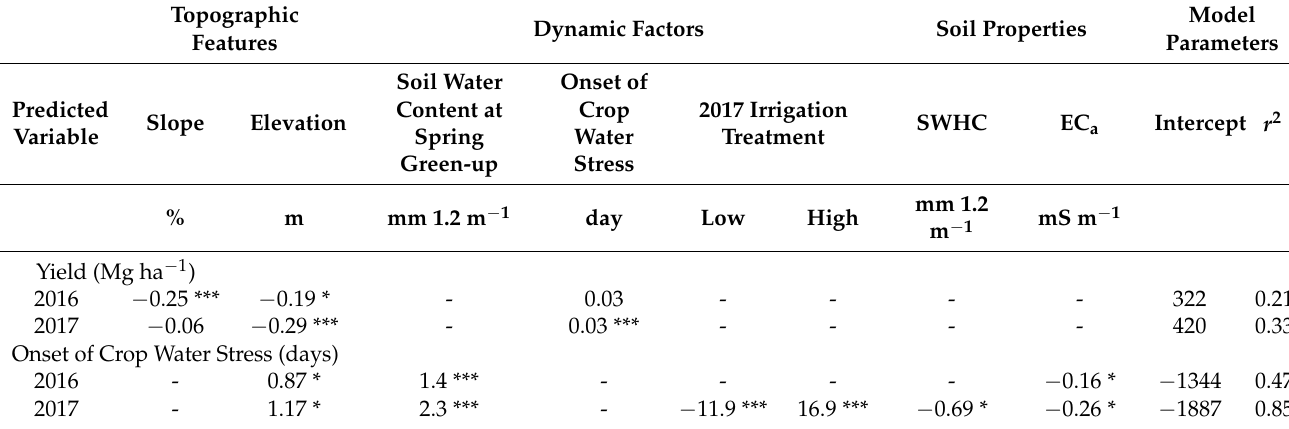
Table 3. Regression model coefficients and performance for predicting yield and the onset of modeled crop water stress as identified through best subset model selection. For variables included in the regression a coefficient and an indication of statistical significance are given. Variables not included in the regression are marked with (-). Variables are grouped according to topographic features, dynamic factors, and soil properties. Each listed regression model was significant ( p -value <